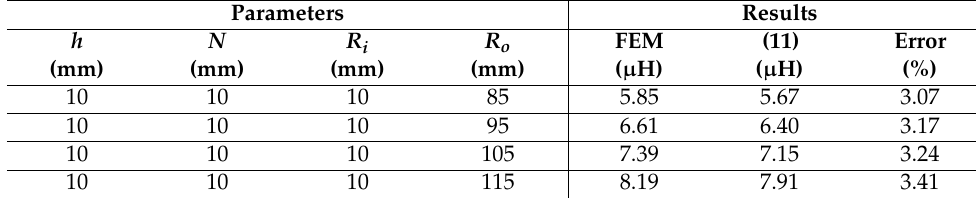
Table 2. Comparison result with variation in outer radius.